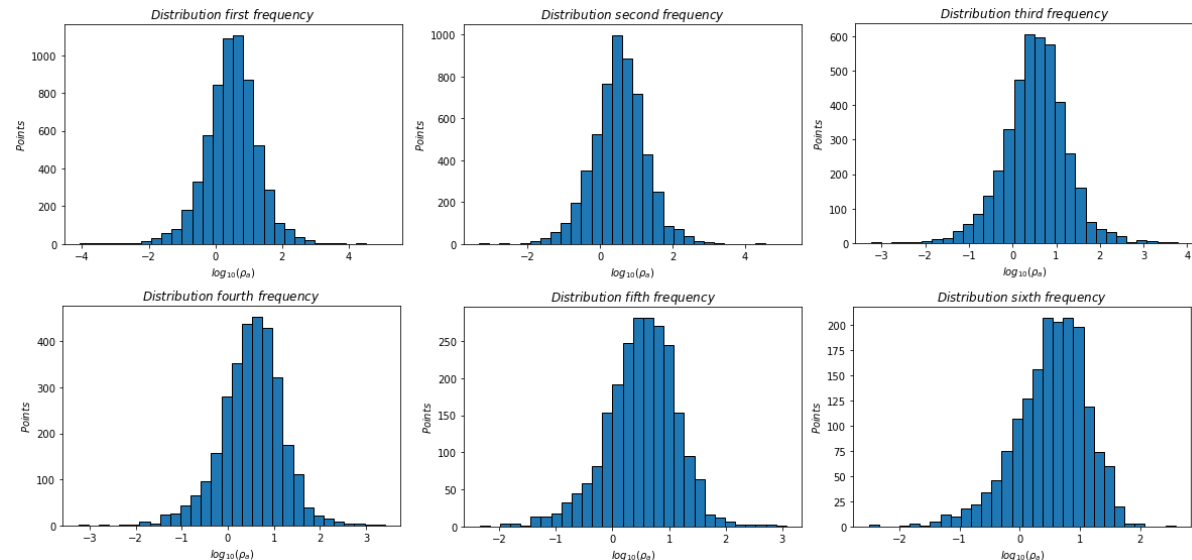
Figure 4. Distribution of the first six frequencies chosen to represent the apparent resistivity curve.